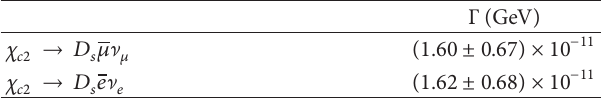
Table 2: Numerical results of decay width for different lepton